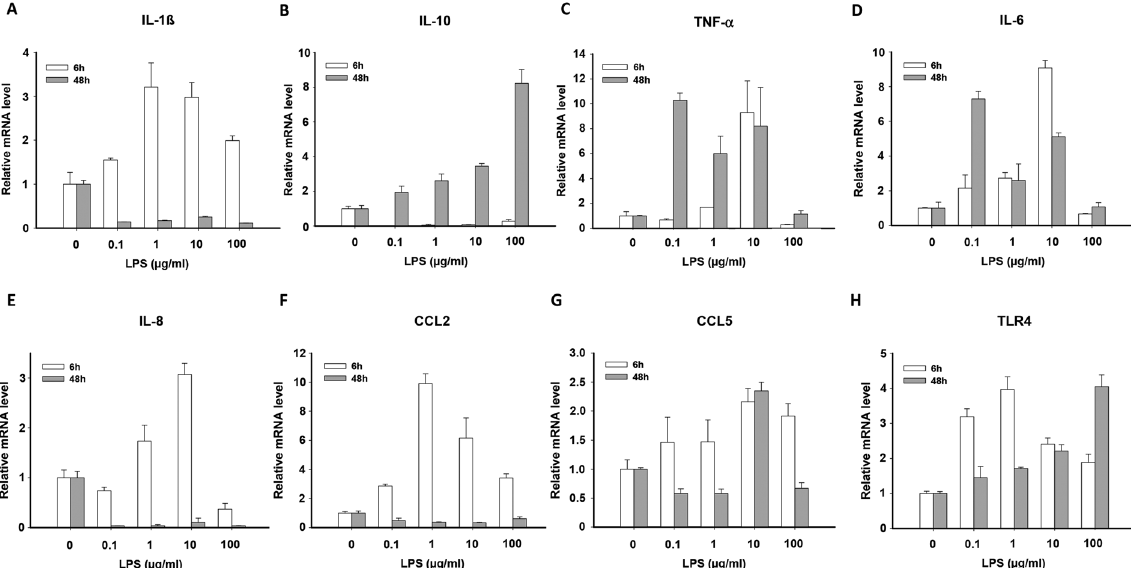
Figure 2. LPS-induced changes in the expression of inflammatory cytokines. Shown are the relative mRNA expression levels of different cytokines after LPS treatment in increasing concentrations for 6 h (white bar) and 48 h (gray bar). 6 hours treatment increased mRNA expression of pro-inflammatory factors IL1 ( A ), IL8 ( E ), CCL2 ( F ), and CCL5 ( G ), while prolonged treatment (48 h) enhanced expression of anti-inflammatory genes of IL10 ( B ). TNF α ( C ) and IL6 ( D ) were increased by LPS-treatment for both 6 h and 48 h. Main LPS-receptor TLR4 ( H ) was time-independently raised by LPS-treatment. p -values (One-way ANOVA) for 6 h- and 48 h-treatment (6 h/48 h): CCL2: 0.008/0.0156; CCL5: 0.0855/0.001; IL-1b: 0.0038/ < 0.0001; IL-6: < 0.0001/0.0002; IL-8: 0.0008/0.005; TLR4: 0.0021/0.0011; TNF- α : 0.0012/0.0171; IL-10: